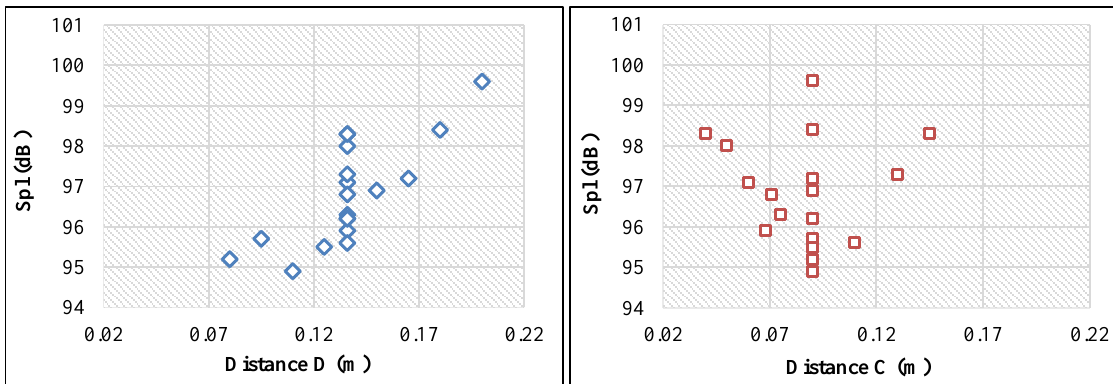
Figure 6. variation in sound level by varition of C and